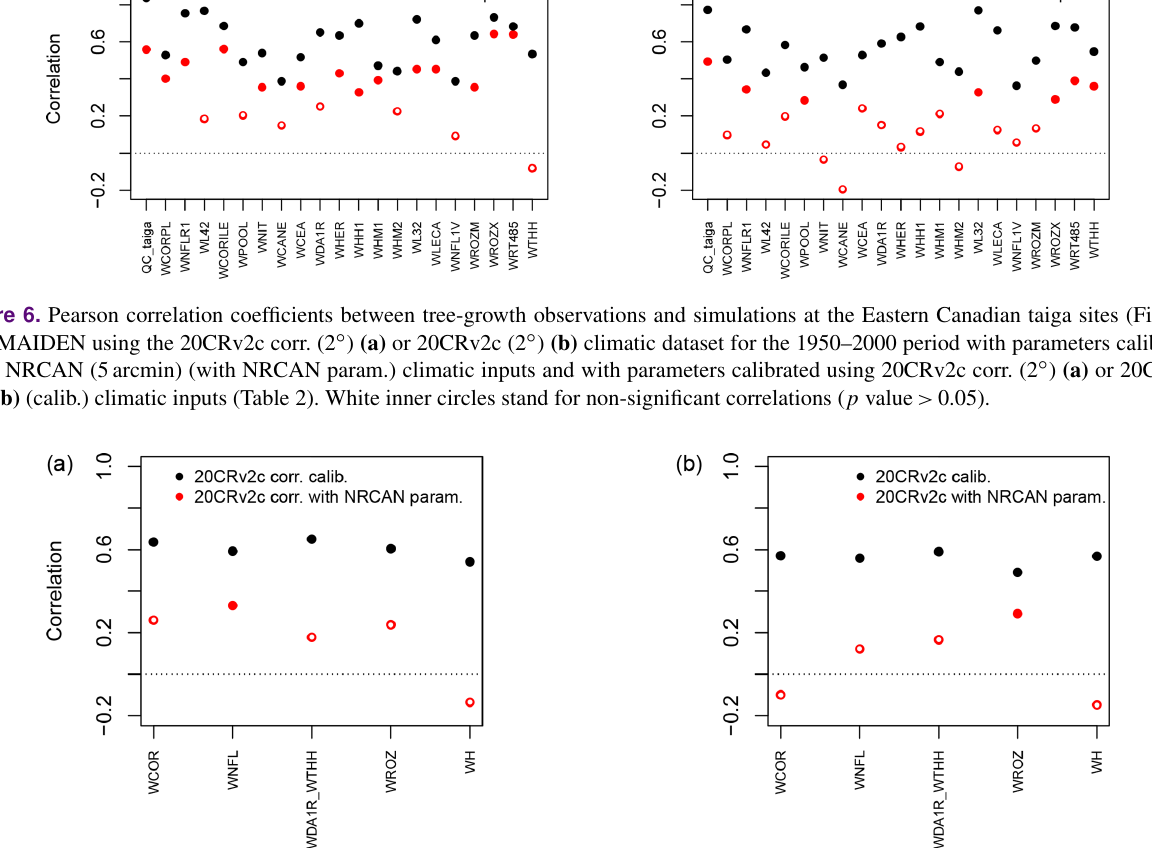
Figure 7. Pearson correlation coefficients between tree-growth observations and simulations at the aggregated Eastern Canadian taiga sites (Fig. 1b) with MAIDEN using the 20CRv2c corr. (2 ◦ ) (a) or 20CRv2c (2 ◦ ) (b) climatic dataset for the 1950–2000 period with parameters calibrated using NRCAN (5arcmin) (with NRCAN param.) climatic inputs and with parameters calibrated using 20CRv2c corr. (2 ◦ ) (a) or 20CRv2c (2 ◦ ) (b) (calib.) climatic inputs (Table 2). White inner circles stand for non-significant correlations ( p value >